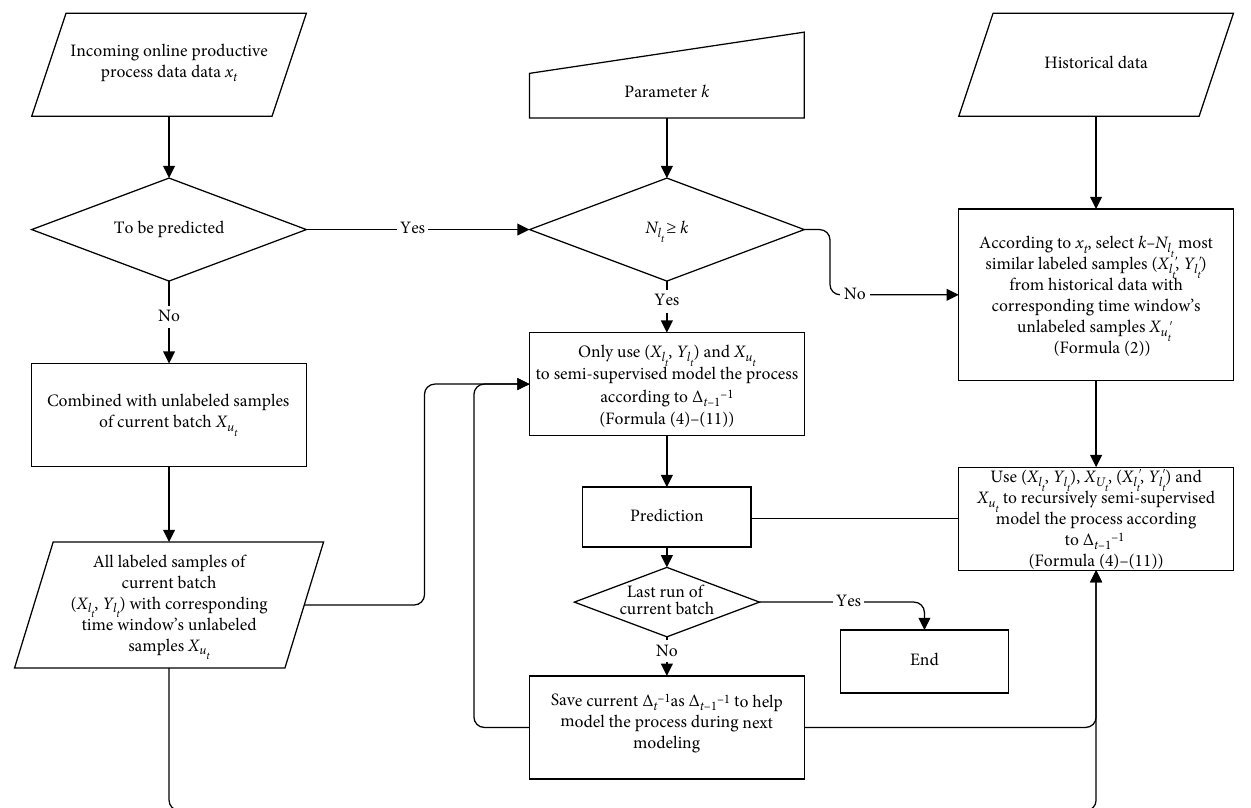
Figure 1: SHLKR flow